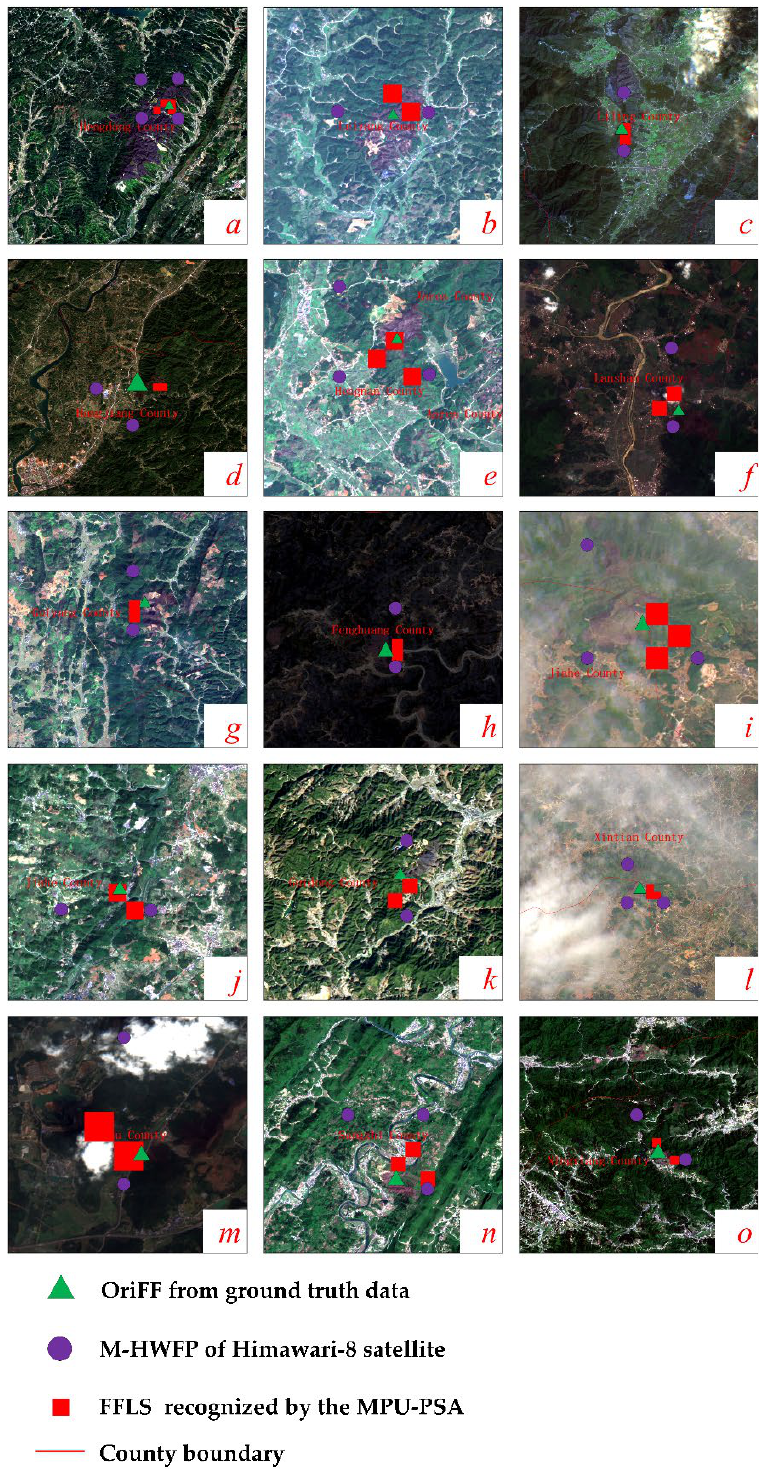
Figure 6. Locations of fifteen forest-fire events detected at subpixel level by the new MPU-PSA method. The improved location-detection of the forest fires occurred in ( a ) Hengdong County (1HeCo), ( b ) Leiyang County (2LeCo), ( c ) Liling County (3LiCo), ( d ) Hongjiang County (4HoCo), ( e ) the junction of Hengnan County and Anren County (5HeCo), ( f ) Lanshan County (6LaCo), ( g ) Guiyang County (7GuCo), ( h ) Fenghuang County (8FeCo), ( i ) Jiahe County (9JiCo), ( j ) Jiahe County (10JiCo), ( k ) Guidong County (11GuCo), ( l ) Xintian County (12XiCo), ( m ) Beihu County (13BeCo), ( n ) Sangzhi County (14SaCo), and ( o ) Ningxiang County (15NiCo).